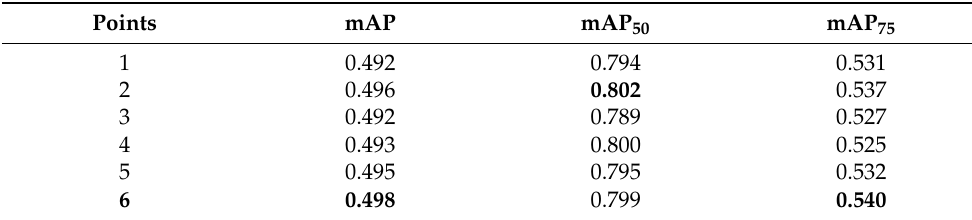
Table 2. Comparison of performance with varying numbers of most similar RoI points.